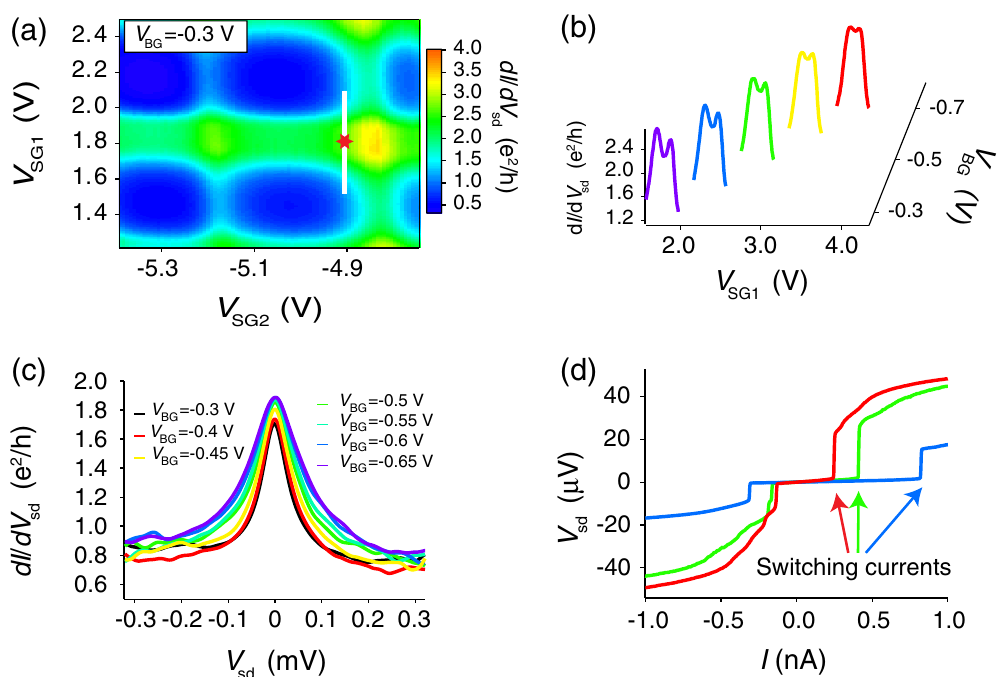
FIG. 2. Kondo correlations and voltage/current characteristics. (a) Zero-bias conductance dI=dV sd vs the sidegate voltages V SG1 and B ¼ 75 mT ) at V ¼ (cid:1) 0 : 3 V , where JJ1 presents a well-established Kondo V SG2 in the normal state (under an applied magnetic field BG ridge for 1 : 7 V < V SG1 < 1 : 95 V and JJ2 has an even occupancy for (cid:1) 5 : 15 V < V SG2 < (cid:1) 4 : 85 V . (b) Zero-bias dI=dV sd conductance vs sidegate voltage V SG1 in the normal state along the white line in panel (a) for five backgate voltages V BG between (cid:1) 0 : 3 V and V (cid:1) 0 : 7 V . V SG2 has been corrected for crosstalk in order to follow the white line, but SG1 is shown as measured. (c) Finite-bias differential conductance dI=dV sd vs source-drain voltage V sd in the normal state, taken in the middle of the Kondo ridge of JJ1 [red star in panel (a), corresponding to a level position (cid:2) 0 ¼ 0 ] for seven backgate voltages V BG between (cid:1) 0 : 7 V and (cid:1) 0 : 3 V . The width of the Kondo resonance is modified by the backgate voltage while (cid:2) 0 and U are kept constant, implying a variation of (cid:1) . (d) Typical superconducting voltage-current characteristics of the nano-SQUID for three arbitrary values of the gate voltages ( V SG1 , V SG2 ). The data are analyzed throughout the paper by recording the switching currents I sw obtained from such voltage-current plots; see Appendix C 1 for information on the experimental